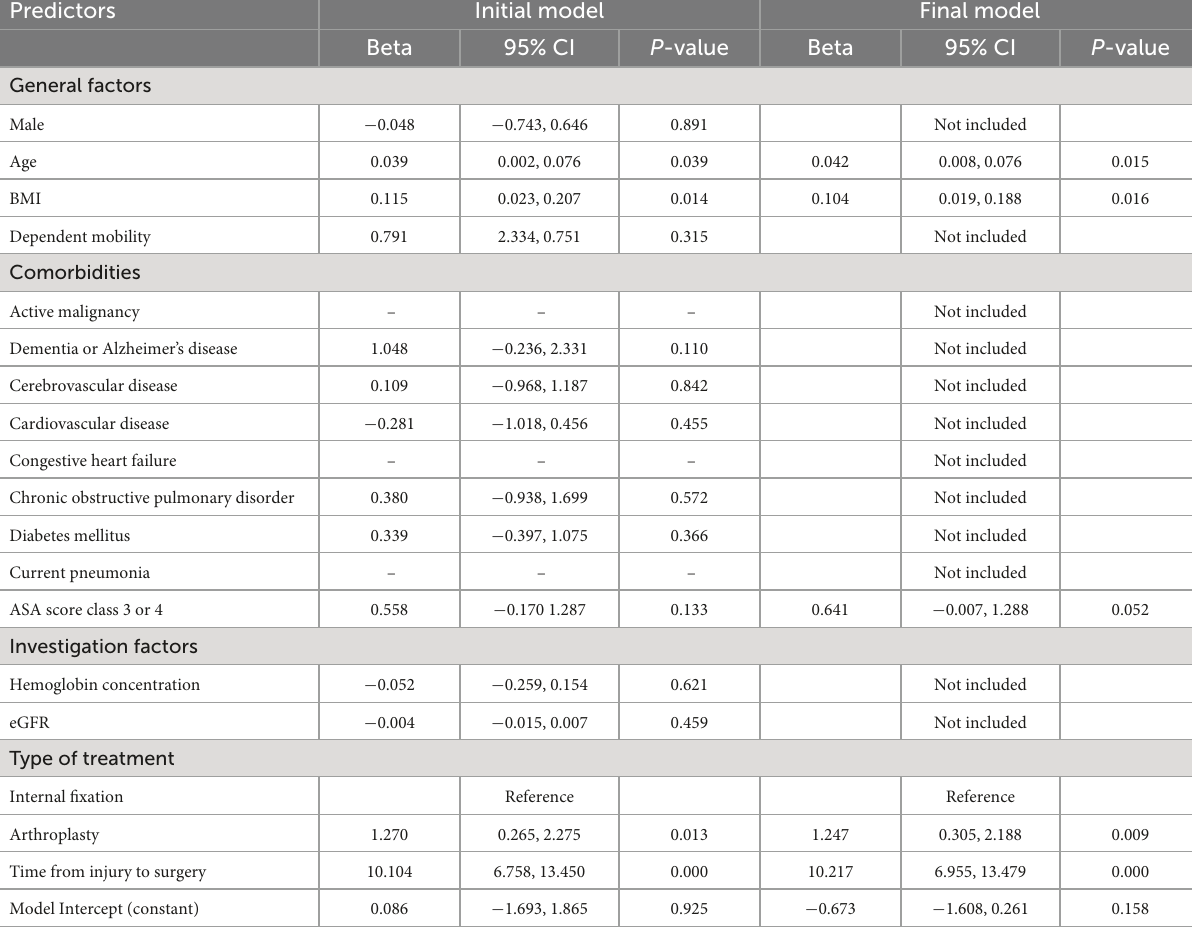
TABLE 2 Multivariable fractional polynomials logistic regression model of the initial model and the final model for prolonged length of stay in patients with osteoporotic femoral neck fracture. Predictors